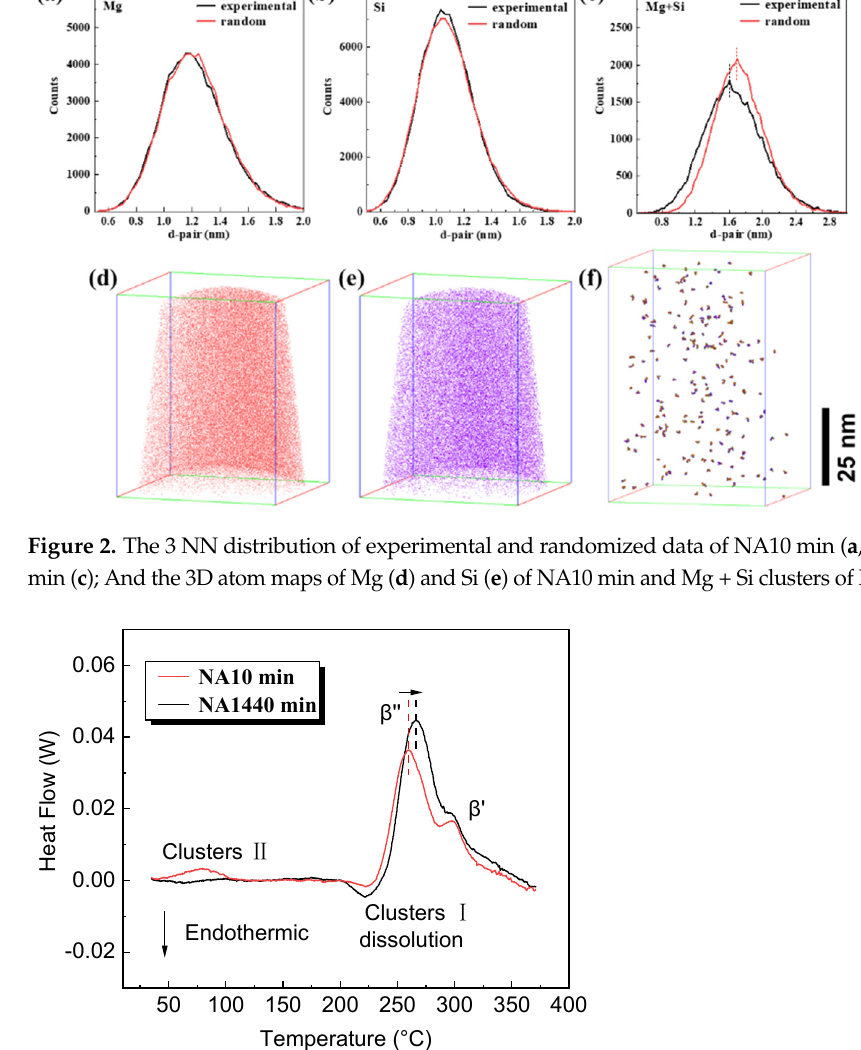
Figure 2. The 3 NN distribution of experimental and randomized data of NA10 min ( a , b ) and NA1440 min ( c ); And the 3D atom maps of Mg ( d ) and Si ( e ) of NA10 min and Mg + Si clusters of NA1440 min ( f ).